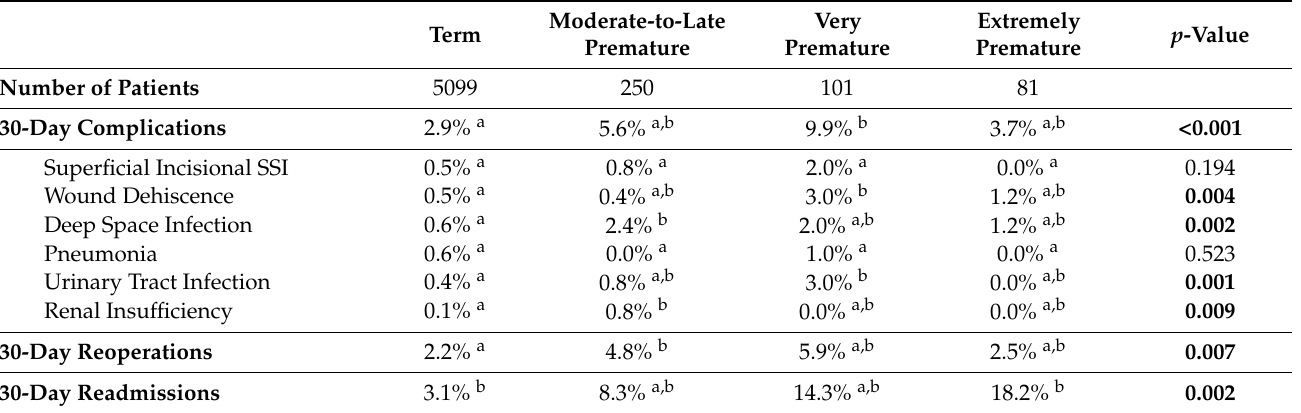
Table 6. Postoperative outcomes across Term ( ≥ 37 weeks), and moderate-to-late prematurity (32 ≤ x < 37 weeks), very premature (28 ≤ x < 32 weeks), and extremely premature (<28 weeks). Dif- ference in superscript letters indicates inter-group differences ( p < 0.05). Bold values are statistically significant ( p <